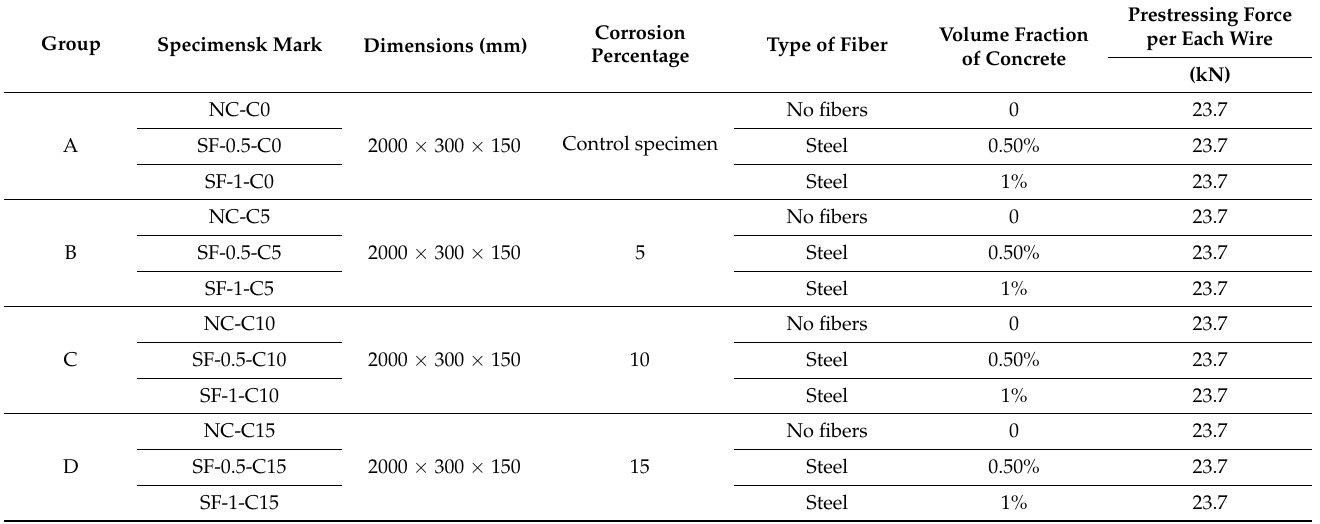
Table 1. Specimens classification and marking specimens based on corrosion level and fiber volume fractions.